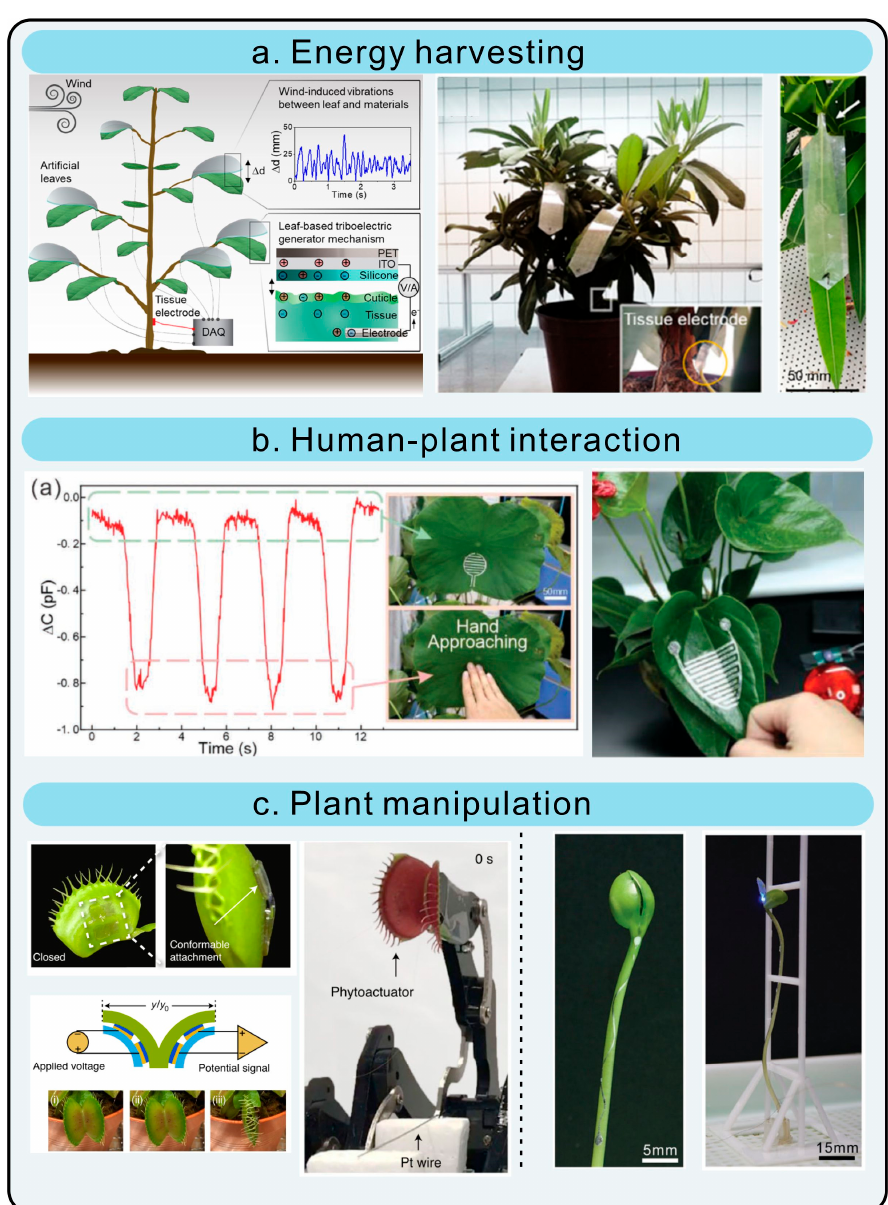
Figure 5. Plant-hybrid systems. ( a ) Energy harvesting system that converts wind energy into electricity (reproduced with permission from [163], copyright © 2020, Wiley-VCH GmbH). ( b ) A human–plant interaction system that can sense hands approaching (reproduced with permission from [31], copyright © 2022, Wiley-VCH GmbH). ( c ) Living plant manipulation systems. Left: manipulating a flytrap to grasp a thin Pt wire (reproduced with permission from [164], copyright © 2021, Springer Nature). Right: manipulating a bean sprout to climb a ladder (reproduced with permission from [16], copyright © 2020, Wiley-VCH GmbH).